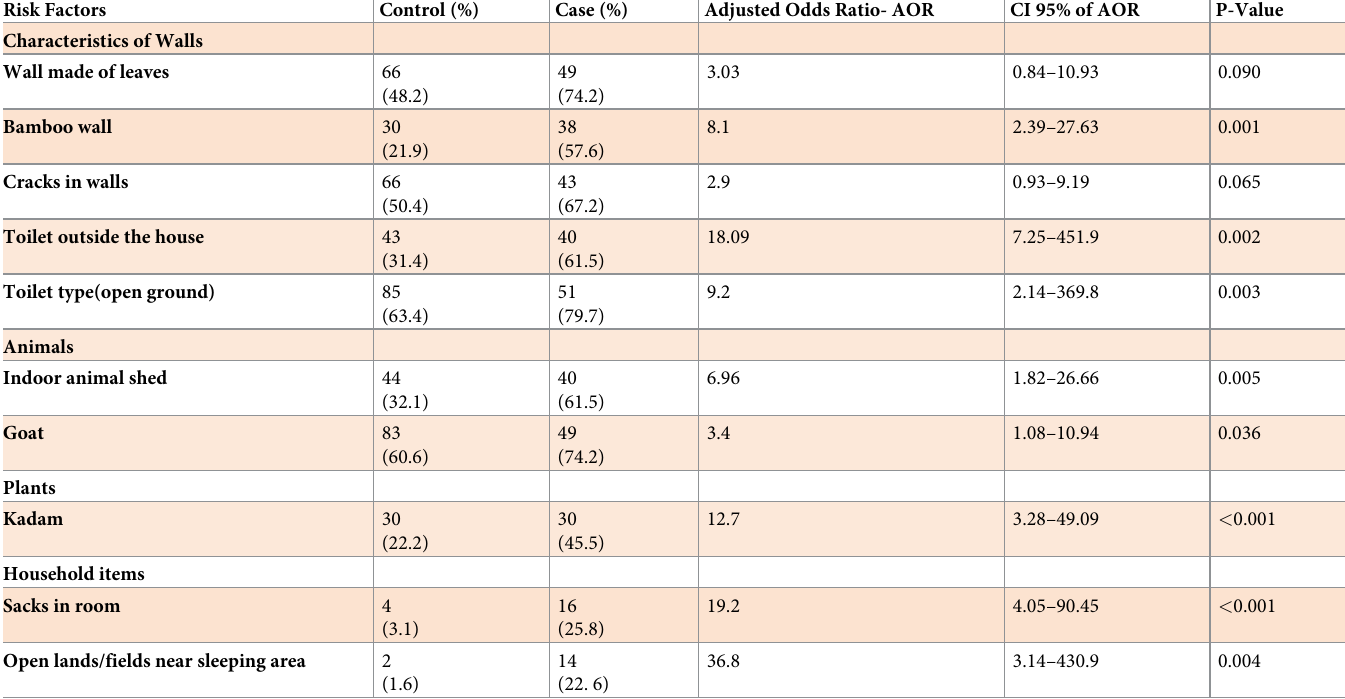
Table 4. Multivariate analysis of risk factors for